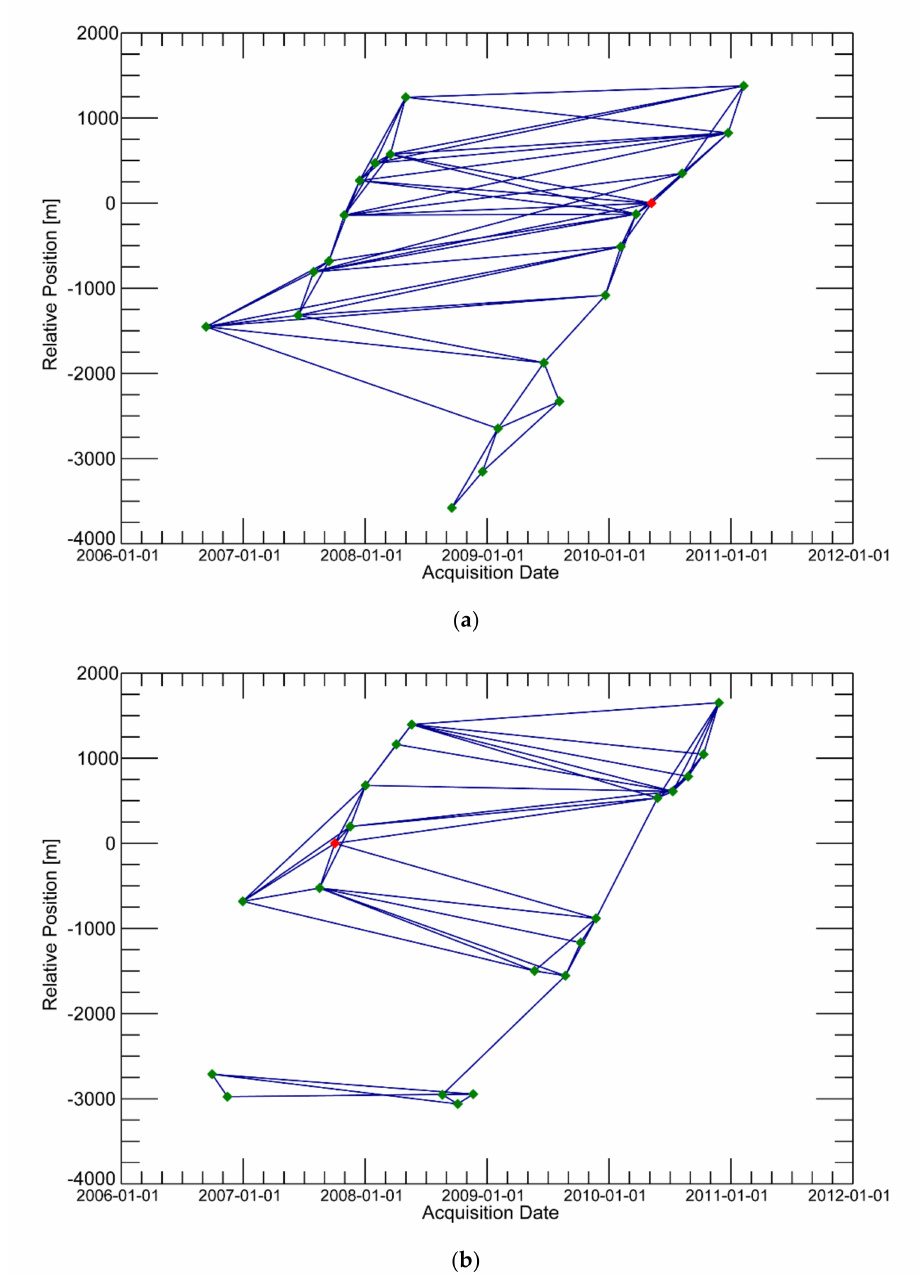
Figure 4. Temporal and spatial baselines for the SBAS-InSAR analysis of ALOS / PALSAR data from the ( a ) ascending orbit, and the ( b ) descending orbit. Red points show the super primary scenes used for the analysis, which the software selected as the scene with the highest number of connections to other